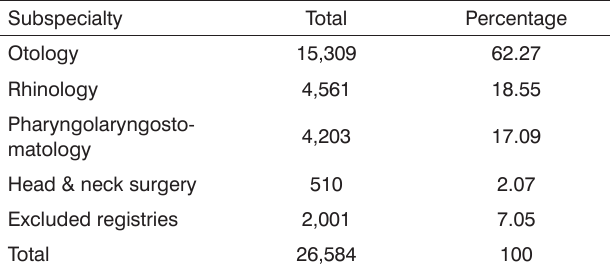
Table 1. Absolute number and percentage of visits to the otorhinolaryngology emergency unit at the Hospital de Base, Federal District, by